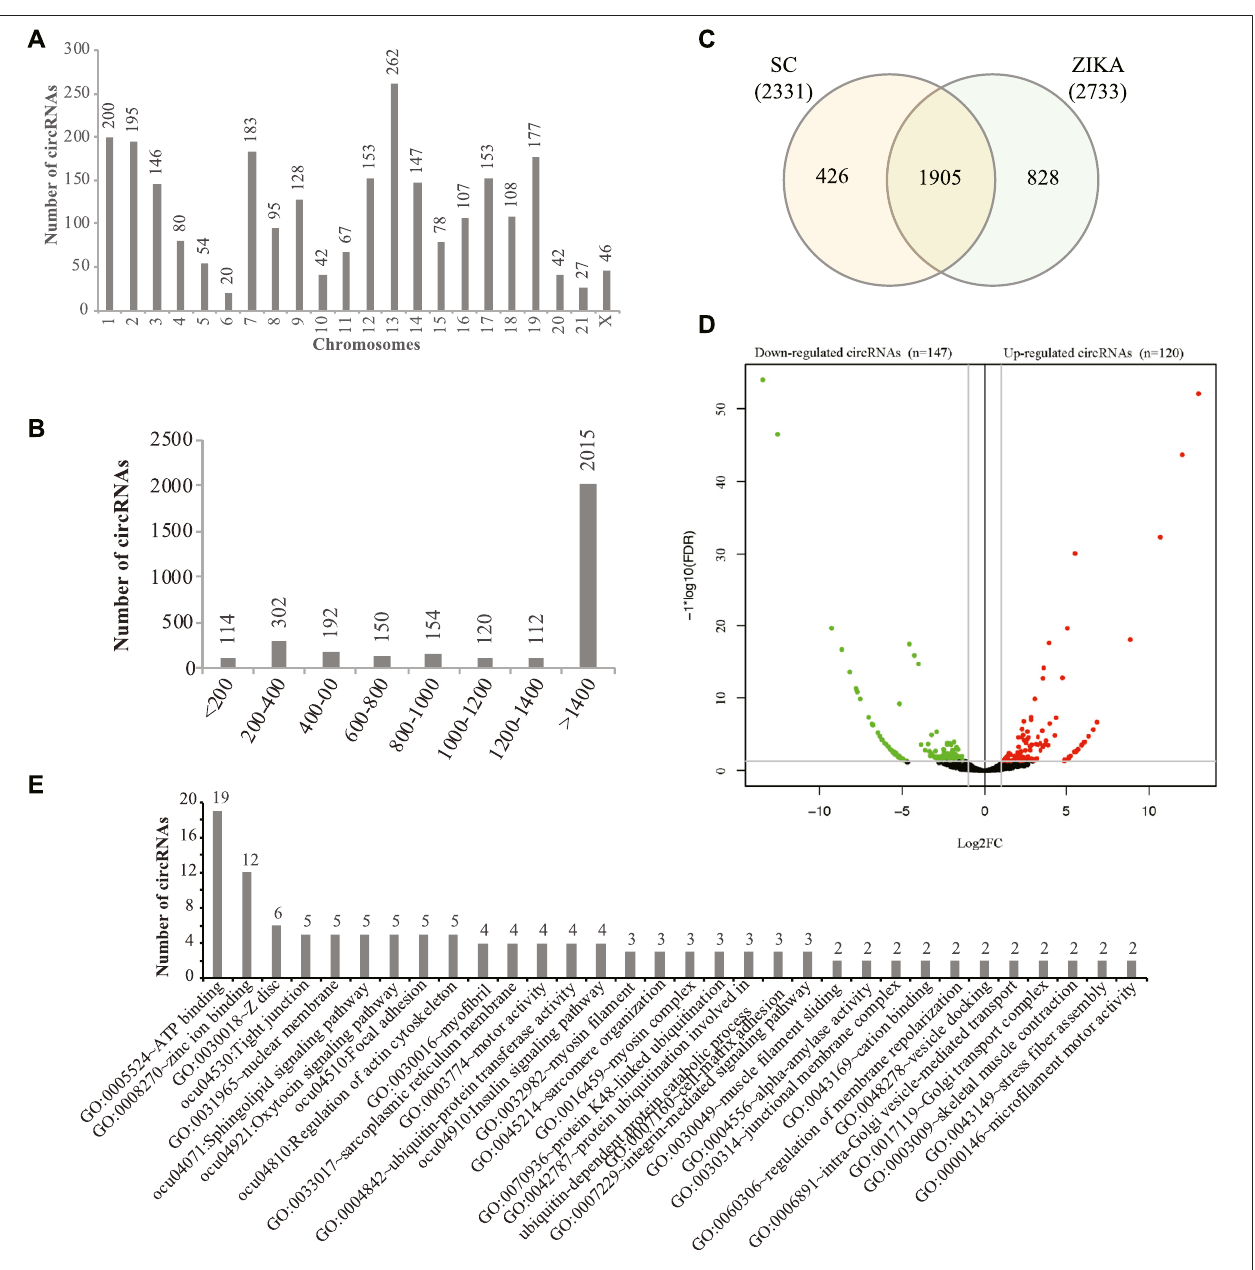
FIGURE 1 | circRNAs identi fi ed in the muscle tissue of SCWrabs and ZIKArabs. (A) Distribution of circRNAs identi fi ed in the rabbit chromosomes. (B) Length distribution of circRNAs identi fi ed in this study. (C) Venn diagram of circRNAs identi fi ed in the muscle tissues of SCWrabs and ZIKArabs. (D) Volcano plot showing differentially expressed circRNAs in the muscle tissues of SCWrabs and ZIKArabs. (E) Functional annotation of the host genes for differentially expressed circRNAs.